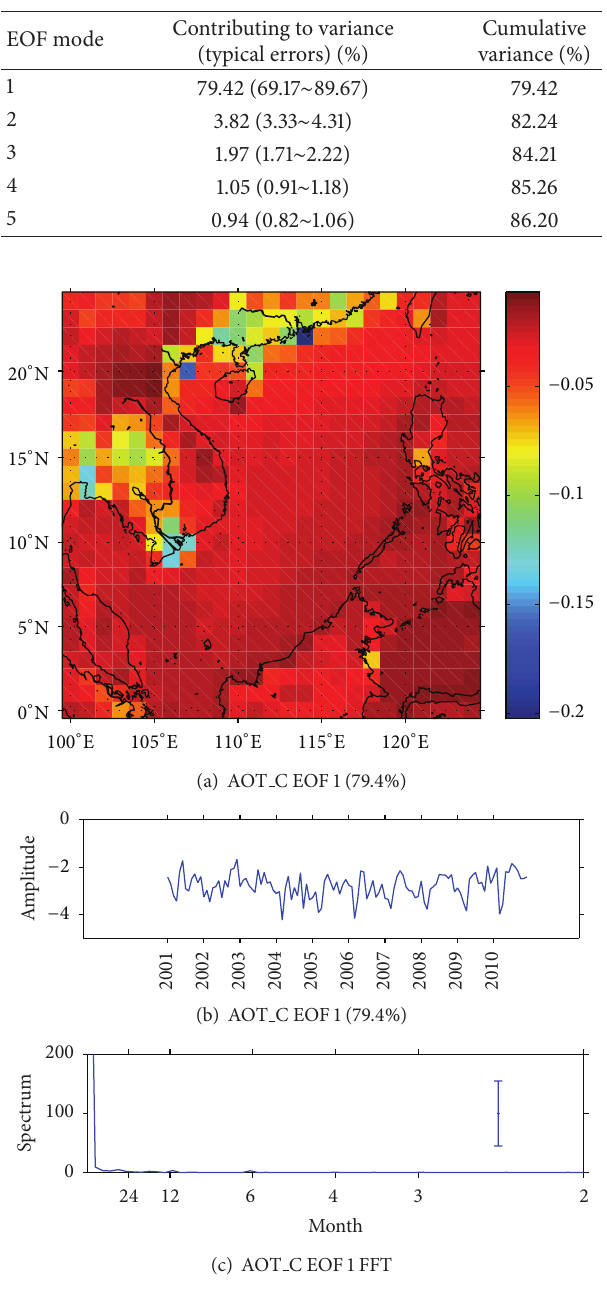
Figure 2: (a) The spatial distribution, (b) its corresponding time- varying amplitude for the vector EOF analysis mode 1 of the AOT C in SCS during 2001/1–2010/12, and (c) the spectrum of (b) with FFT. The line segment represents the 95% confidence interval.